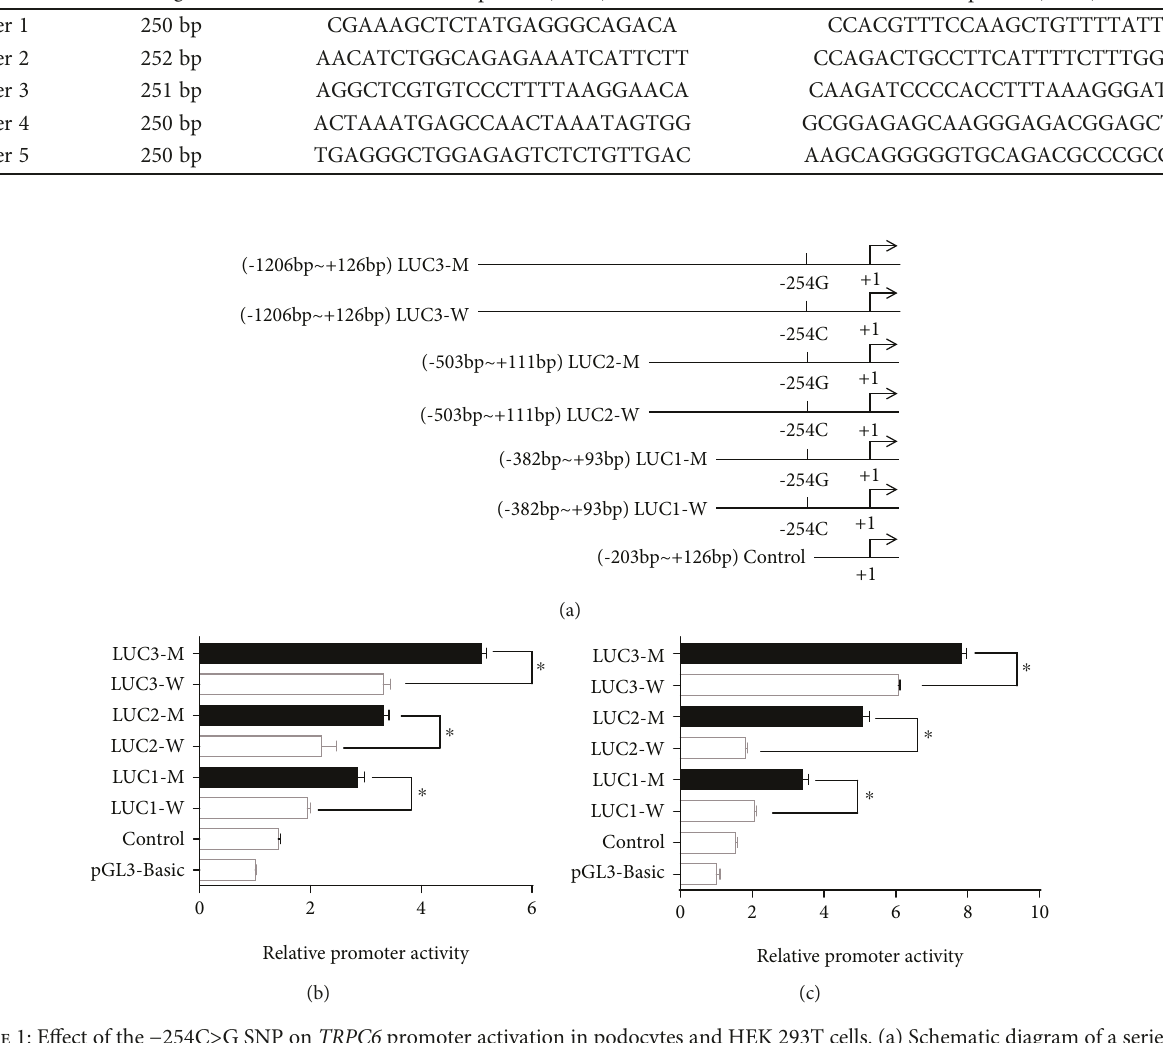
Table 2: Primers designed for amplifying the promoter region of the TRPC6 gene used in the ChIP-PCR assay. Primer